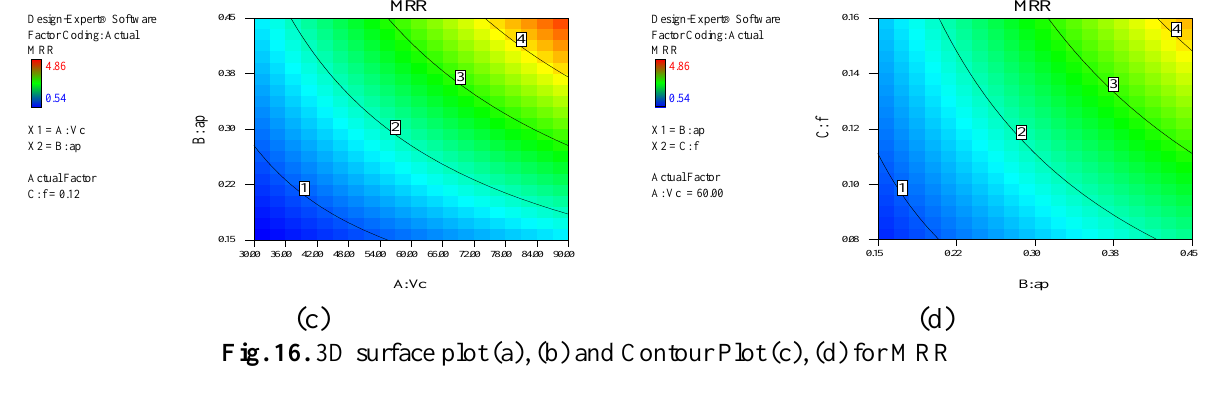
Fig. 16. 3D surface plot (a), (b) and Contour Plot (c), (d) for MRR